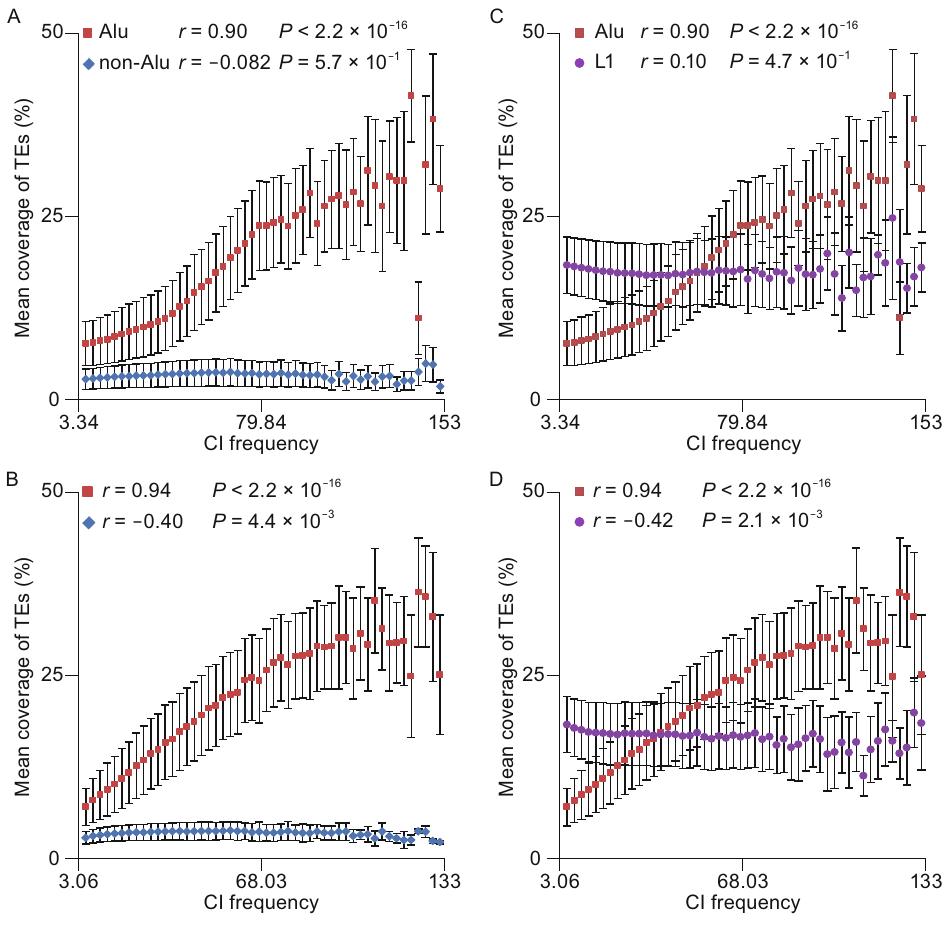
Figure 2. MC of SINE/ Alu , SINE/non- Alu , and LINE/L1 in each frequency bin. (A) In hESC, the MCs of Alu were positively correlated with CI frequencies ( r = 0.90, P < 2.2 × 10 16 ), but the MCs of SINE/non- Alu were not correlated with CI frequencies ( r = − 0.082, P = 0.57). (B) Although the MCs of Alu were also positively correlated with CI frequencies in IMR90 fi broblasts ( r = 0.94, P < 2.2 × 10 16 ), the MCs of SINE/non- Alu in IMR90 fi broblasts were negatively correlated with CI frequencies ( r = − 0.40, P = 0.0044). (C) Different patterns of the correlation of the MCs of Alu and L1 with CI frequencies were observed in hESC, with a positive correlation of Alu and no correlation of L1 ( r = 0.11, P = 0.47). (D) In IMR90 fi broblasts, on the contrary of the positive correlation of the MCs of Alu , the MCs of L1 were negatively correlated with CI frequencies ( r = − 0.42, P =